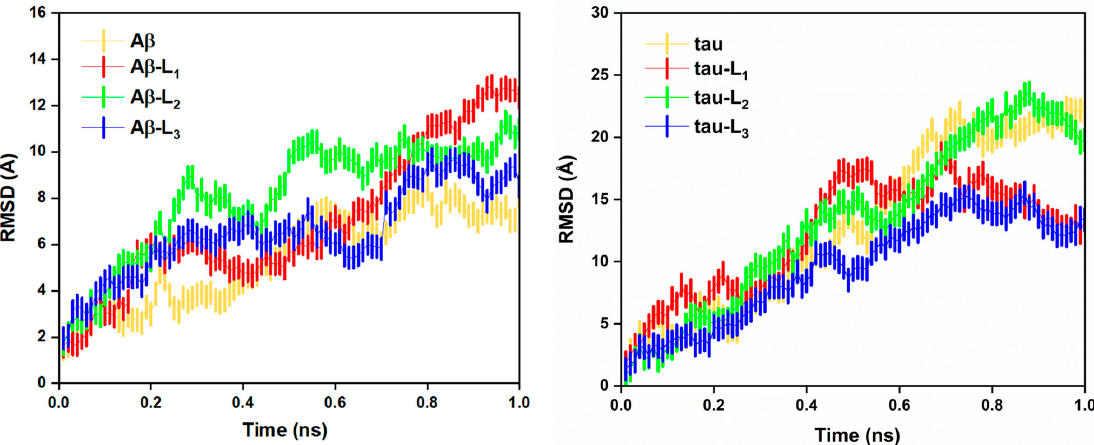
Figure 5. Root-mean-square deviation (RMSD) plots of A β and p-tau in both apo (in yellow) and with inhibitor-bound forms (L 1 , L 2 , and L 3 are in red, green, and blue respectively) in the molecular simulation of 1 ns.